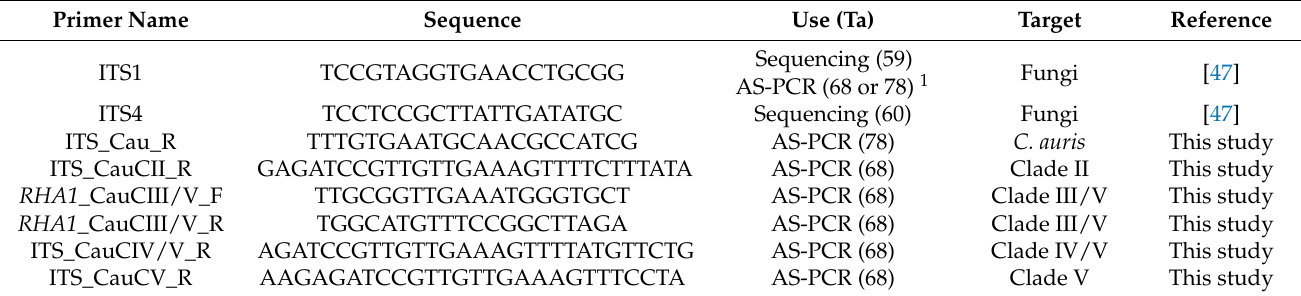
Table 1. Primers used in this study. The specific annealing temperature (Ta) is given in ◦